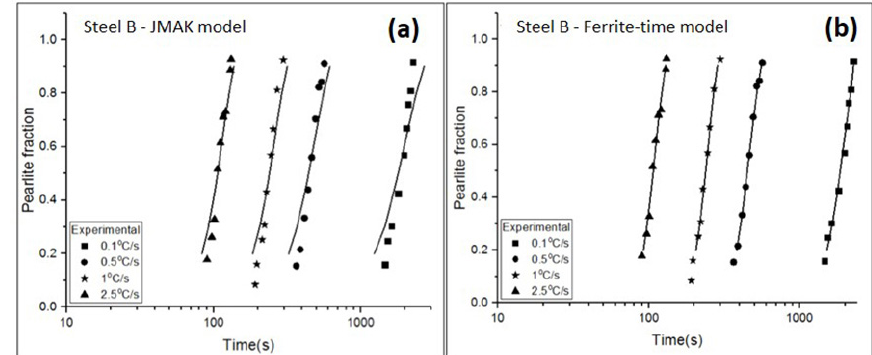
Figure 9. Pearlite fraction as a time function. (a) JMAK and (b) Ferrite-time equations fitted to the steel B experimental data.